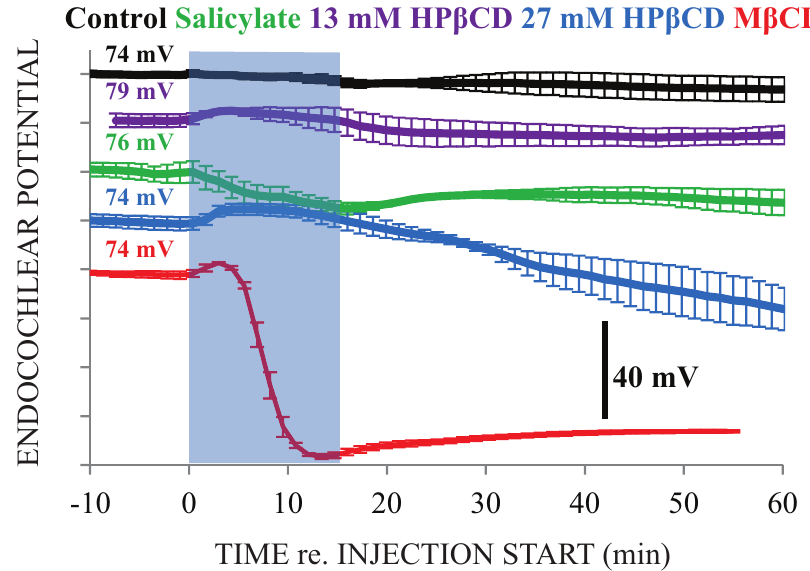
Fig 3. Endocochlear potential (EP) measuredfrom inside the endolymphatic space of the third cochlear turn. The blue rectangleidentifiesthe 15-minute injection. Voltagesto the left of the rectangleare the averageEP from ~10 minutes before the injectionstart. Measurement ranks along the y-axis indicate which solutioncaused the largest effect, smallest effects are at the top of the figure and largest effects at the bottom. Injectionof artificial perilymphalone (control) did not affect EP. Injectionof 13 mM HP β CDand salicylatecaused slight and temporary effects. Treatment with 27 mM HP β CD did not abolishthe EP but M β CDcaused total abolition.N = 3 for each treatment